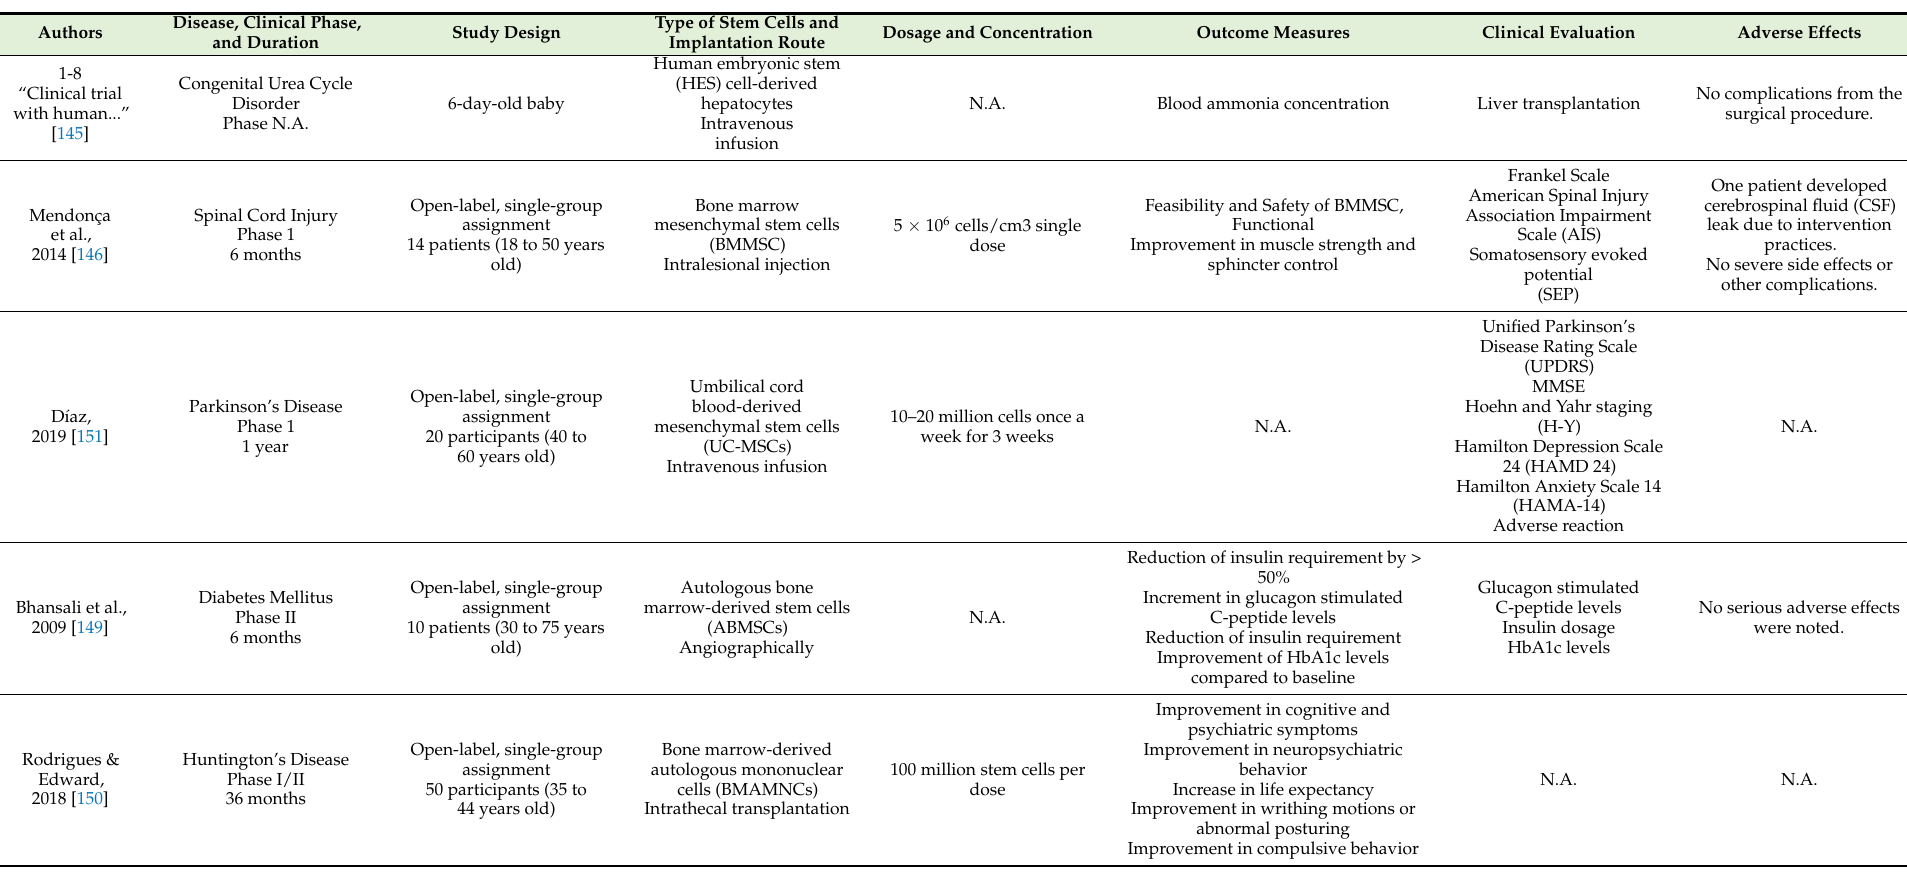
Table 2. Present clinical studies of stem cell therapies in